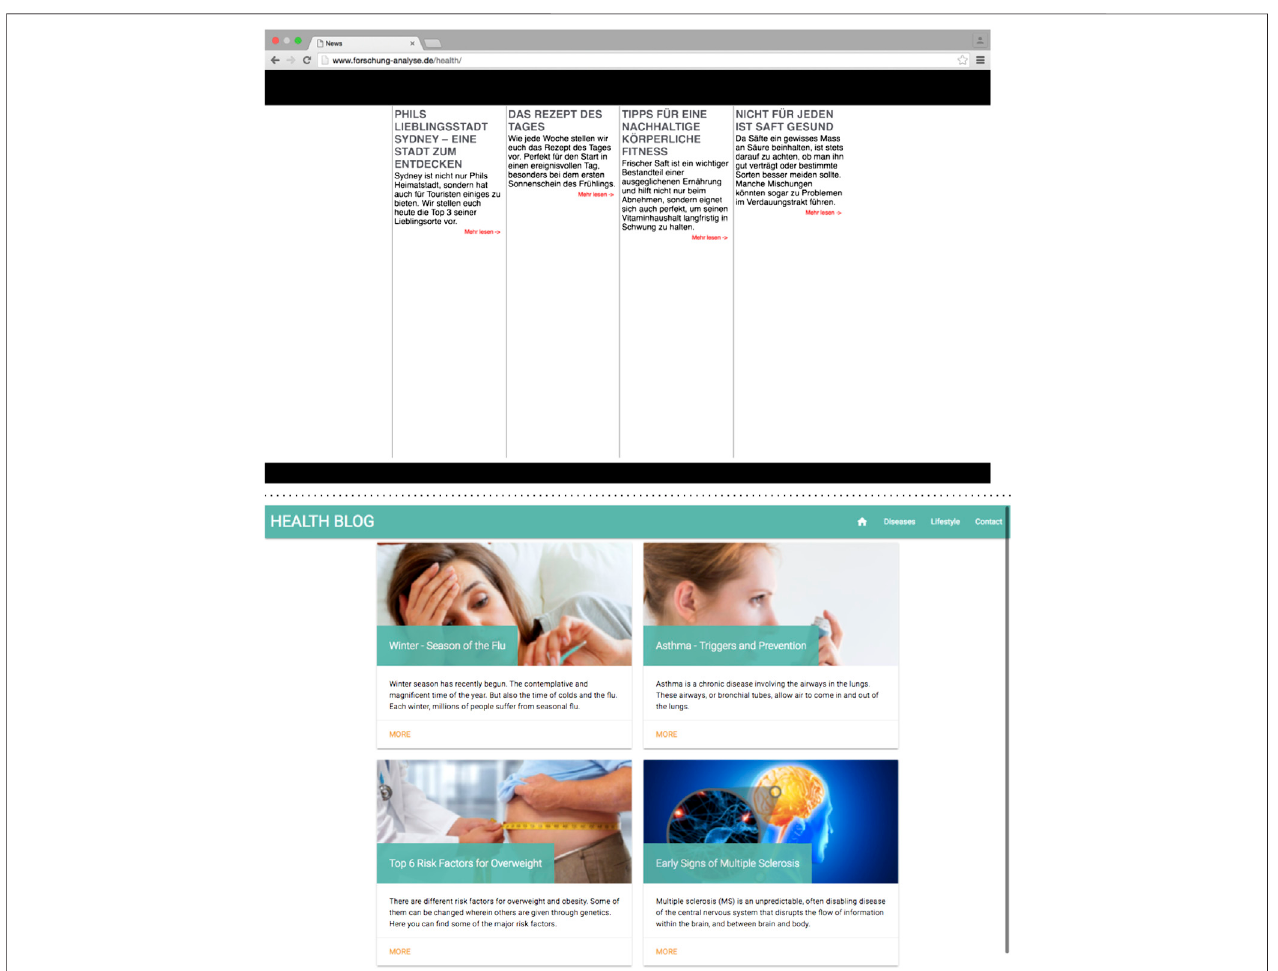
FIGURE A1 | Mock-up websites used for information selection in study 1 (top) and study 2 (bottom) .